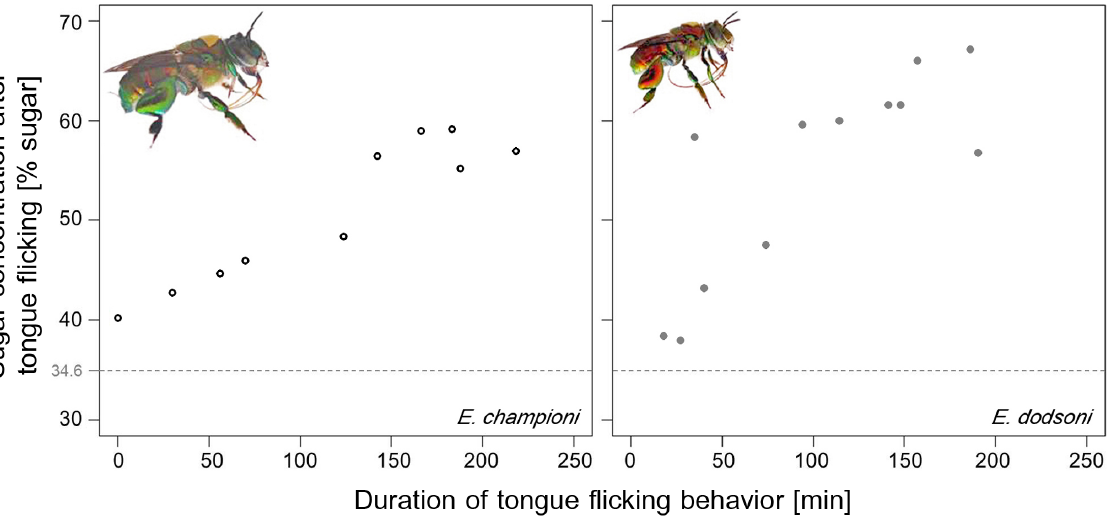
Figure 5. Positive correlation between tongue flicking behavior and resulting sugar concentration of crop contents. Exemplary presentation of the results for an initial sugar concentration of 34.6%. Left graph: E. championi : Spearman rank correlation, n 5 10, P , 0.01, rho 5 0.87; right graph: E. dodsoni : Spearman rank correlation, n 5 12, P , 0.01, rho 5 0.76. Each circle or dot represents the values for a different individual